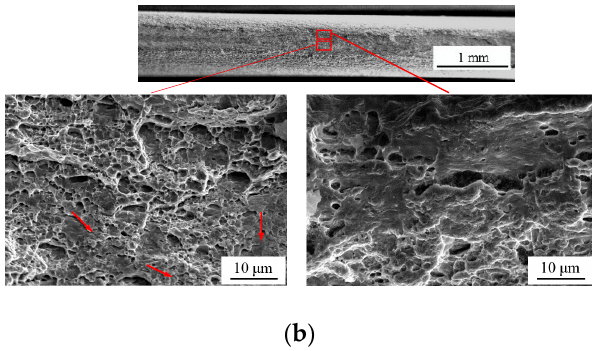
Figure 11. Fracture morphology of notched specimens: ( a ) NT-R3 and ( b ) NT-R9.